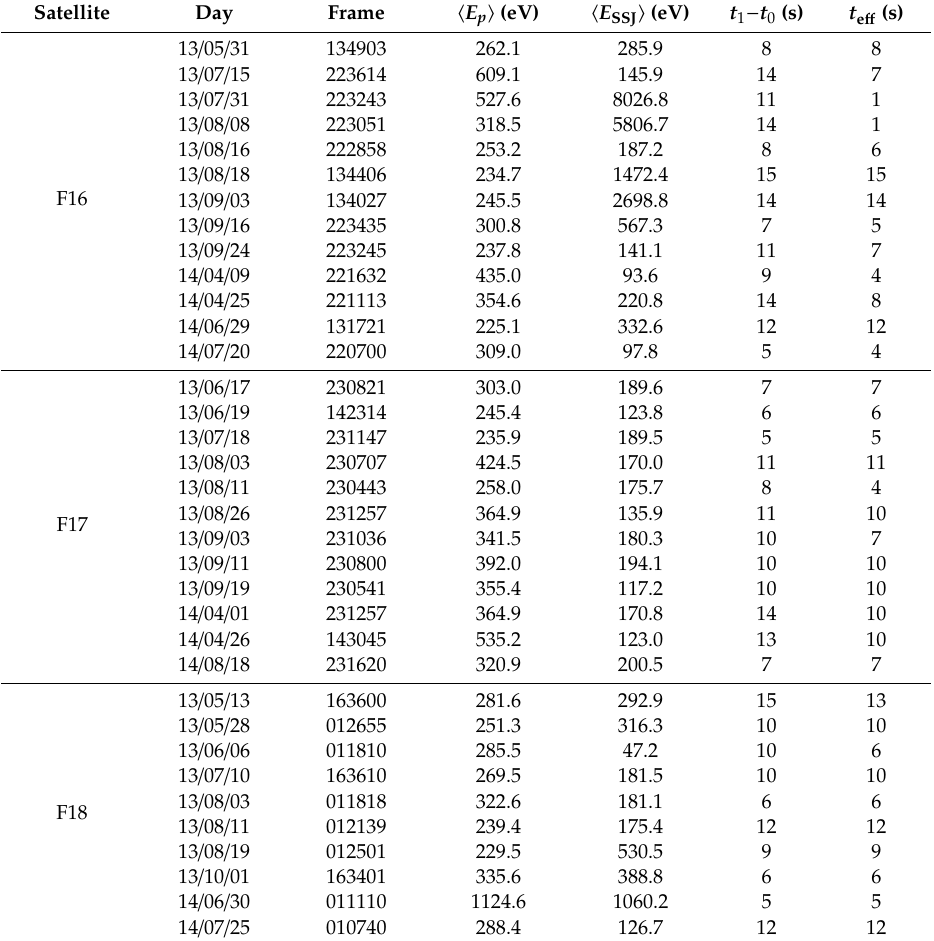
Table 4. Estimations from both auroral spectral data (ASD) and acquired data by Special Sensor J5 (SSJ5) particle detector concerning various joint observing events.